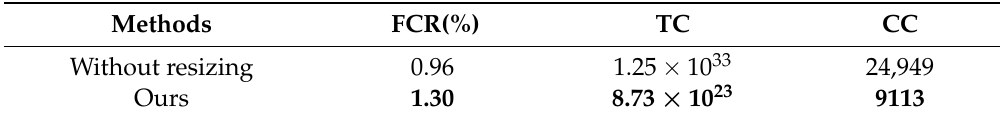
Table 2. Comparisons between the evaluation metrics of the results of the synopsis of Video 2 from (a) the traditional method without tube resizing and (b) the proposed method with dynamic and adaptive online tube